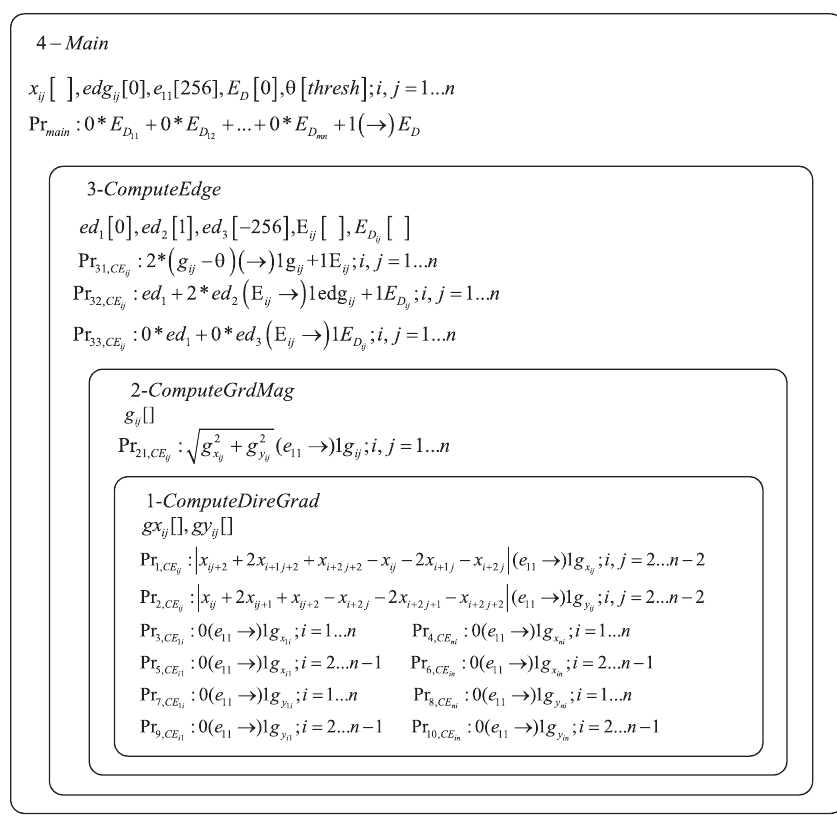
Figure 2. The structure of EDENP.